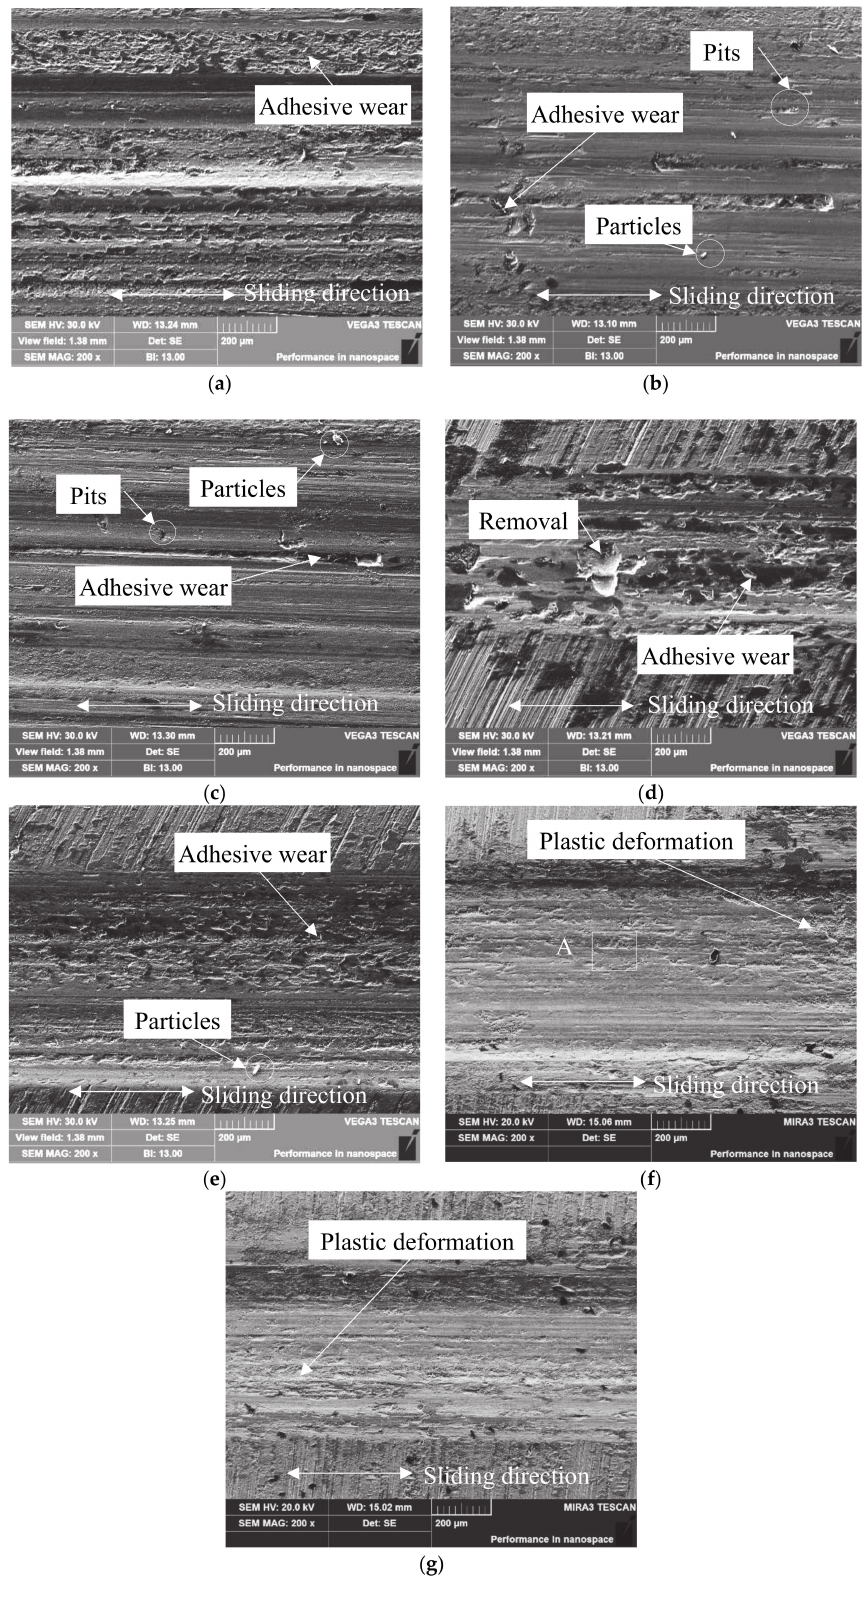
Figure 7. SEM images of the worn surfaces of untreated AISI H11 specimens tested at: ( a ) 50 N / 83.3 mm · s − 1 / 298 K, ( b ) 100 N / 83.3 mm · s − 1 / 298 K, ( c ) 150 N / 83.3 mm · s − 1 / 298 K, ( d ) 100 N / 16.7 mm · s − 1 / 298 K, ( e ) 100 N / 50 mm · s − 1 / 298 K, ( f ) 100 N / 16.7 mm · s − 1 / 343 K, ( g ) 100 N / 16.7 mm · s − 1 / 373